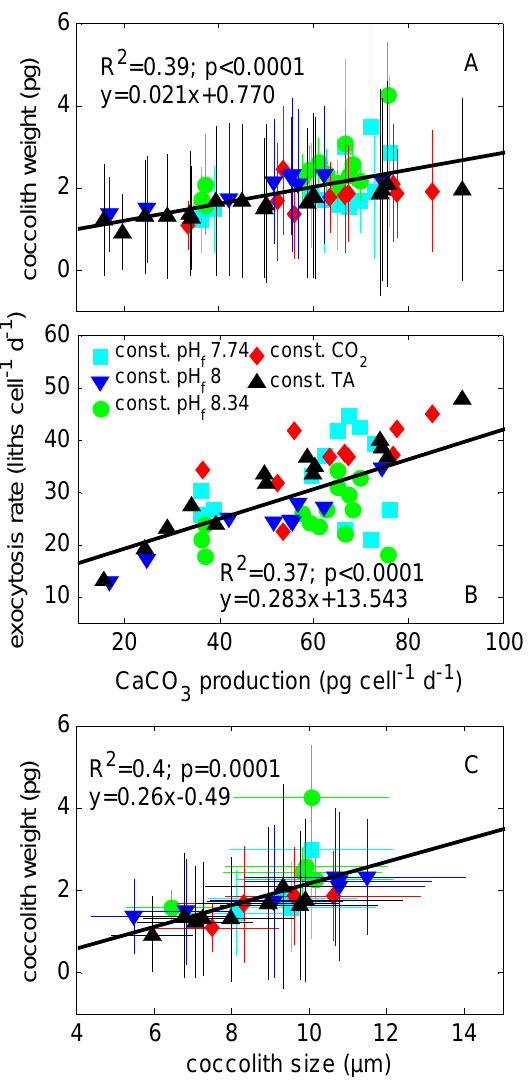
Fig. 6. Coccolith weight, production and size. (A) Correlation be- tween cellular CaCO 3 production rate and mean coccolith weight. (B) Correlation between cellular CaCO 3 production rate and the number of coccoliths formed per day. (C) Correlation between coc- colith size and weight. Error bars denote the standard deviation from measured mean weight or size of all coccoliths of a treatment. Re- gression line shows a fit through data from all experiments with fit equation and significance given in the figure. Note that the correla- tion does not apply equally well for individual